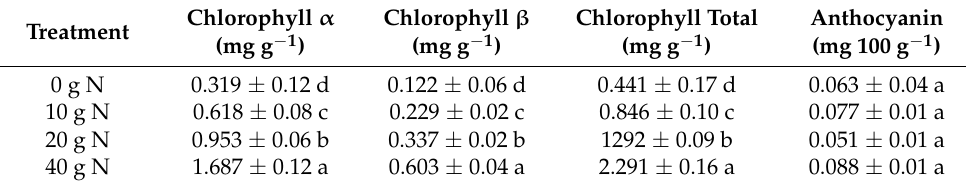
Table 5. Kaffir lime leaves’ pigment content under different nitrogen-fertilizer